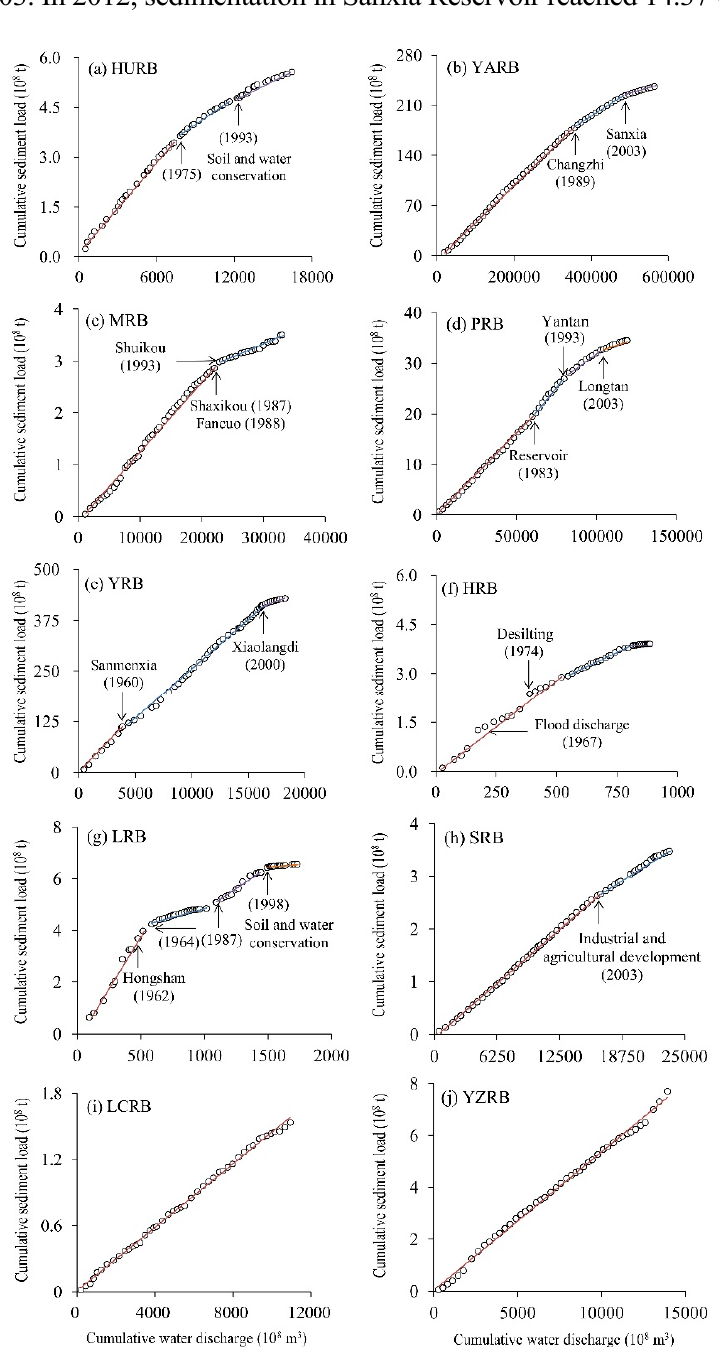
Figure 4. Double mass curve of streamflow versus sediment